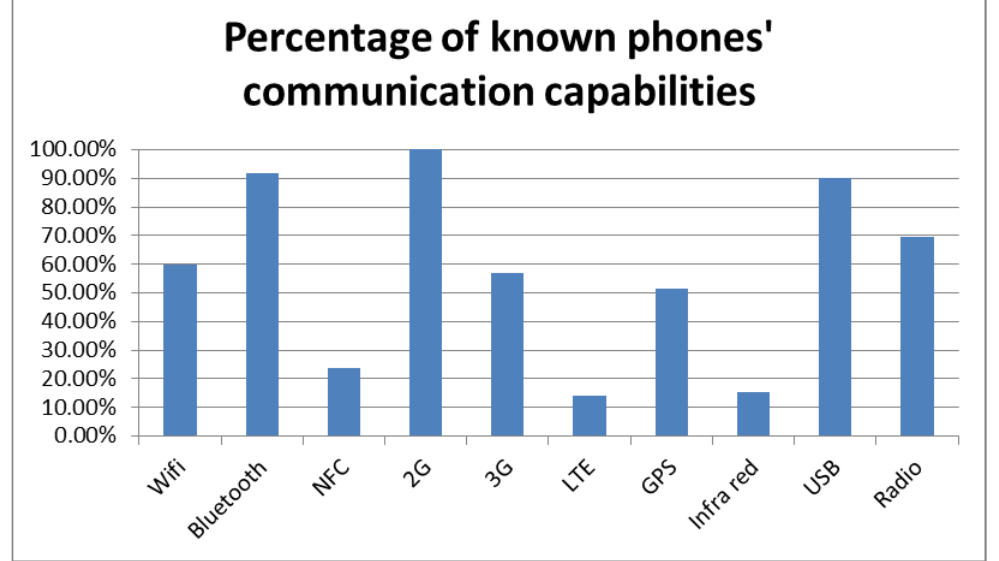
Figure 2: Communication capabilities of known mobile